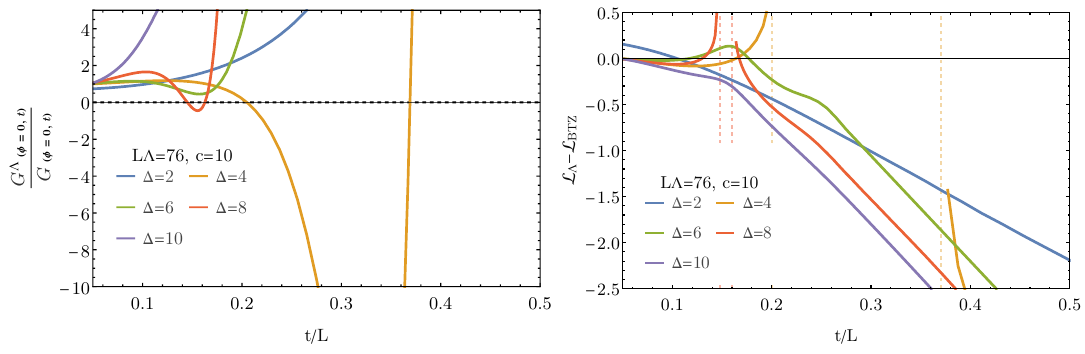
Figure 8 . Normalized Wightman function with (cid:12)nite cuto(cid:11) (left) and length di(cid:11)erence from BTZ (right) as a function of time for (cid:12)xed L (cid:3) = 76, (cid:12)=L = 1 = 2, L = 2 (cid:25) and c = 10. The space separation is